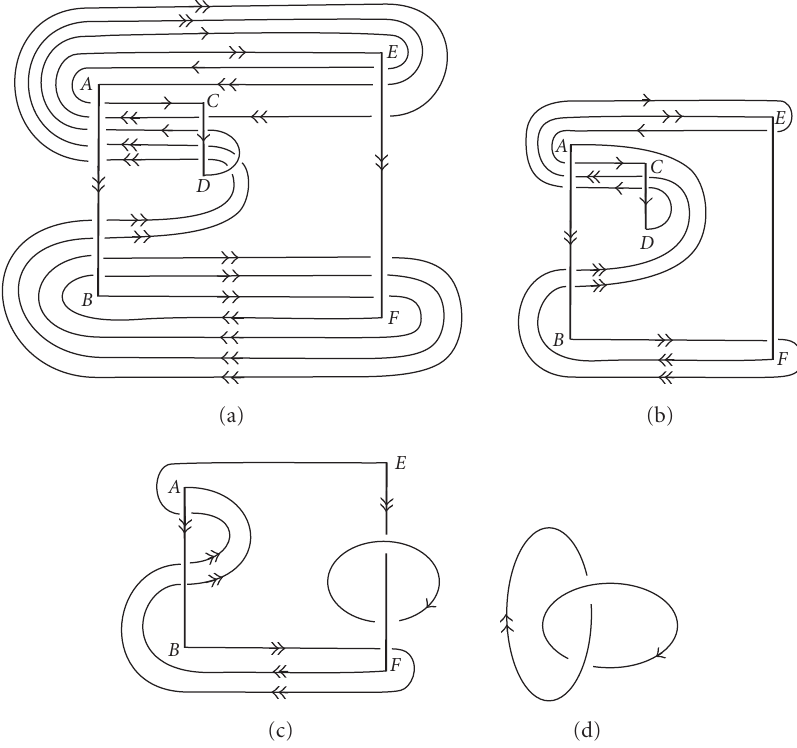
Figure 4.3. A sequence of Reidemeister moves yielding the Hopf